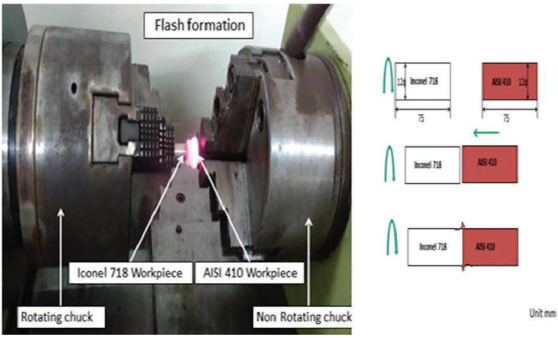
Figure 2: Te machine setup for welding. Table 3: Welding